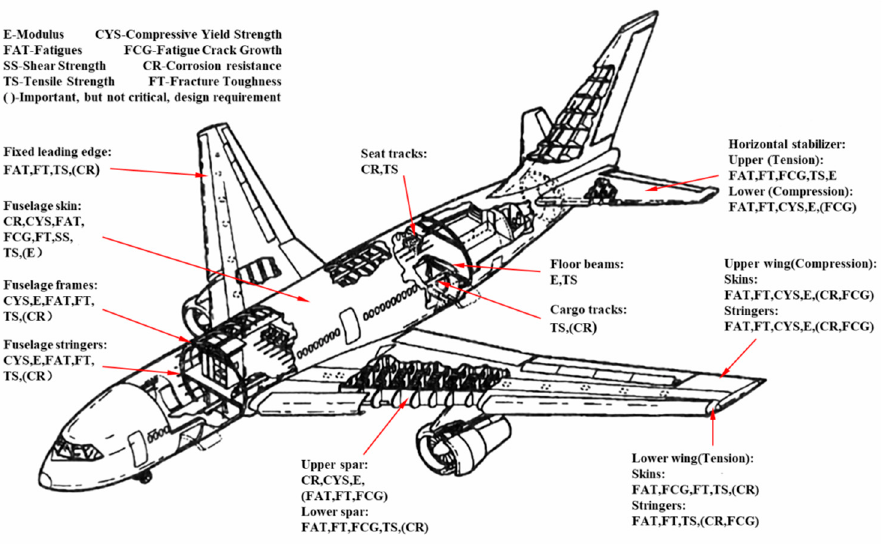
Figure 6. Performance requirements of the aircraft materials [25,35,38,39]. (Adapted with permission from ref. [35]. Copyright 1996 Elsevier).